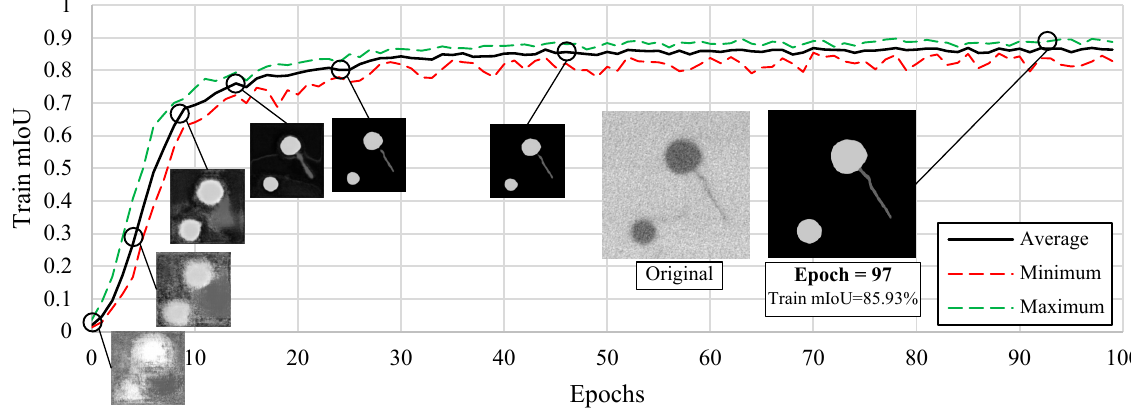
Figure 13. Training mIoU of U-Net (depth = 3) at each epoch; training is repeated 10 times and minimum, average, and maximum values of mIoU on training set are calculated.